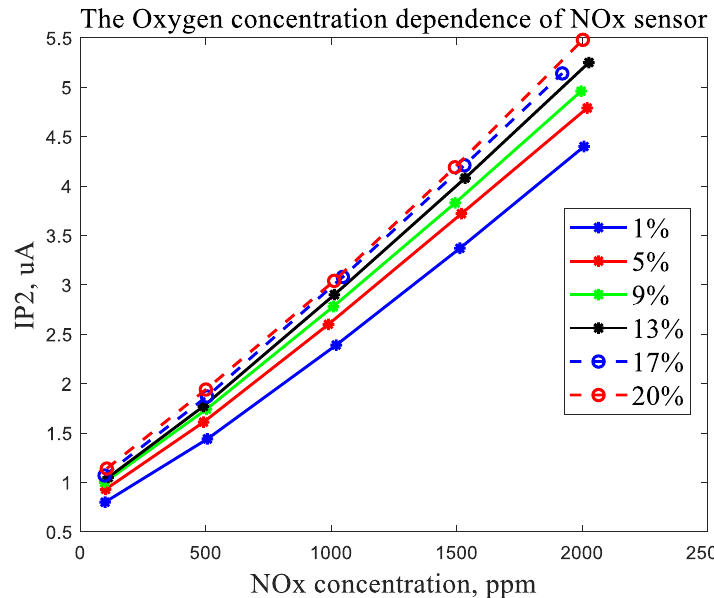
Table 4. The calibration parameters of the NOx sensor for oxygen concentration dependence.